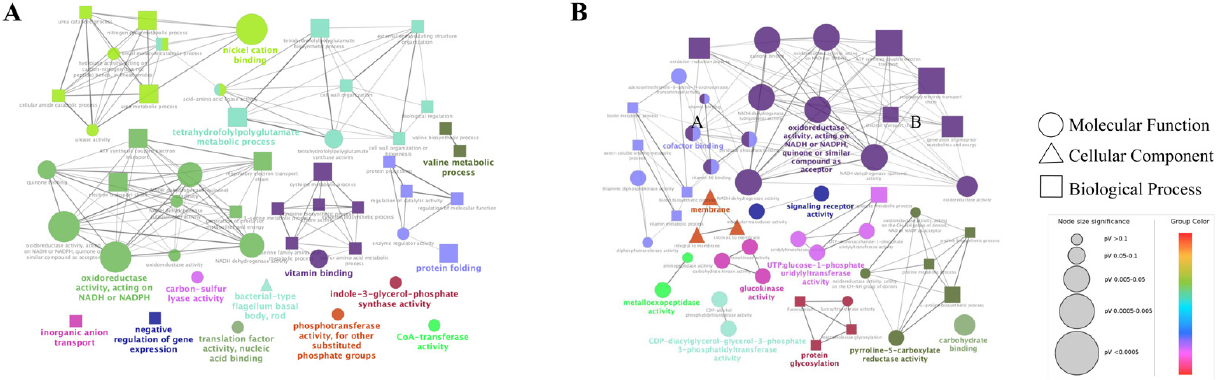
Figure 6. Analysis of GO enrichment for H. pylori 3192 biofilm under different treatments. Top 10 GO terms in the cellular component (CC), molecular component (MF), and biological process (BP) are shown. Rich factor refers to the ratio of DEGs enriched in the pathway to the number of genes annotated. The greater the value is, the higher the enrichment degrees. The size of the solid circle represents the number of DEGs enriched in this pathway, and the color represents the significance of enrichment. FIC group: 1 × FIC of AMX and CLR, CF7 group: 6.25% CFS of 10 7 CFU/mL L. sali- varus LN12 in combination with 1 × FIC of AMX and CLR, CF9 group: 6.25% CFS of 10 9 CFU/mL L. salivarus LN12 in combination with 1 × FIC of AMX and CLR. ( A ): CF7 group vs. FIC group, ( B ): CF9 group vs. FIC group.